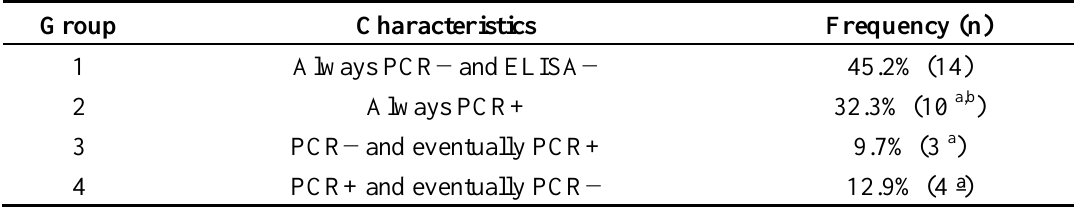
Table 4. Classification into groups of the goats according to the evolution of the viral infection (PCR) and humoral immune response (ELISA) in milk throughout the study period (March through